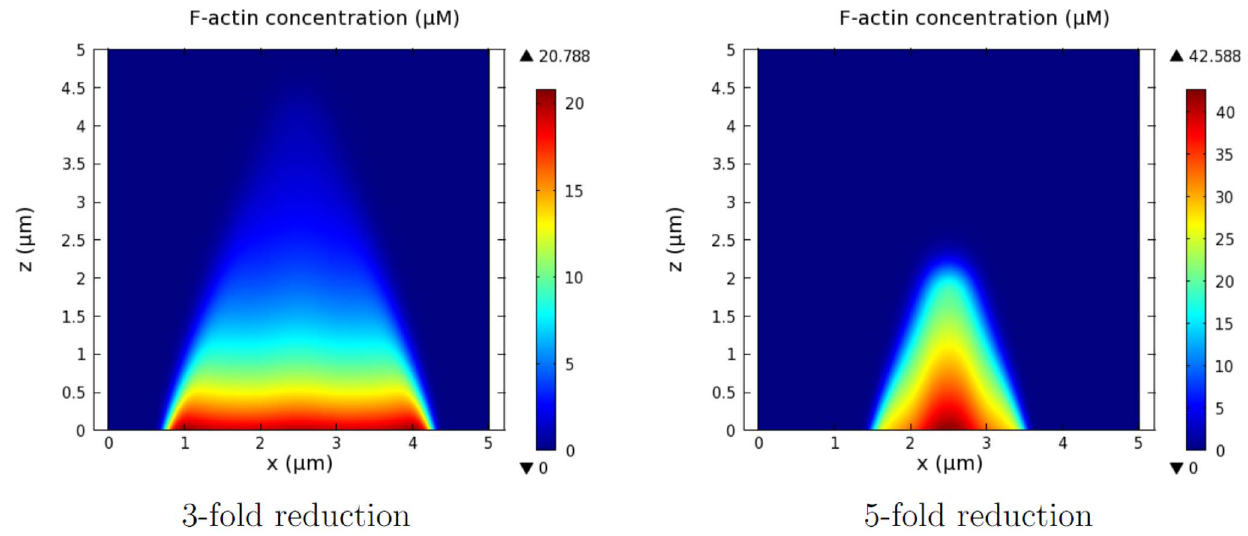
Figure 13. F-actin structures without coronin activity. Lower effective debranching rates caused by lack of coronin activity lead to altered actin structures. (Left) 3-fold reduction. (Right) 5-fold reduction.